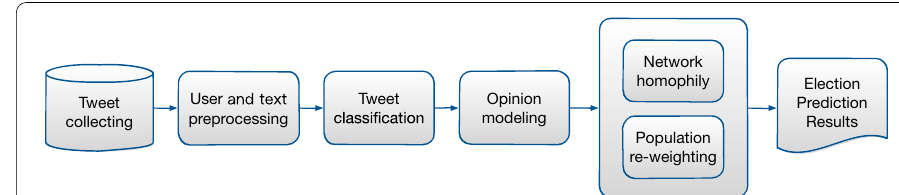
Fig. 4 The flow of the election prediction algorithm relying on machine learning and network theoretical tools for opinion